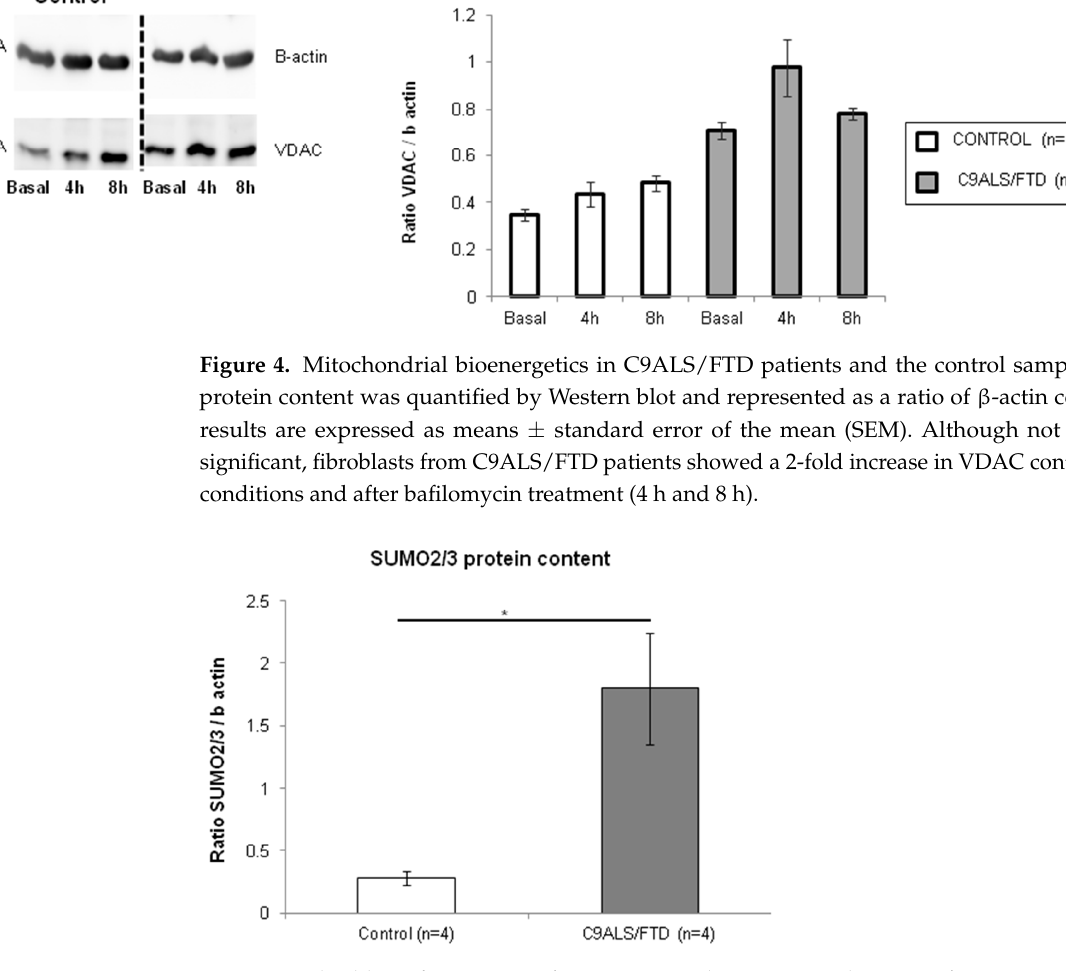
Figure 4. Mitochondrial bioenergetics in C9ALS/FTD patients and the control samples. VDAC protein content was quantified by Western blot and represented as a ratio of β‐ actin content. The results are expressed as means ± standard error of the mean (SEM). Although not statistically significant, fibroblasts from C9ALS/FTD patients showed a 2 ‐ fold increase in VDAC content at basal conditions and after bafilomycin treatment (4 h and 8 h).